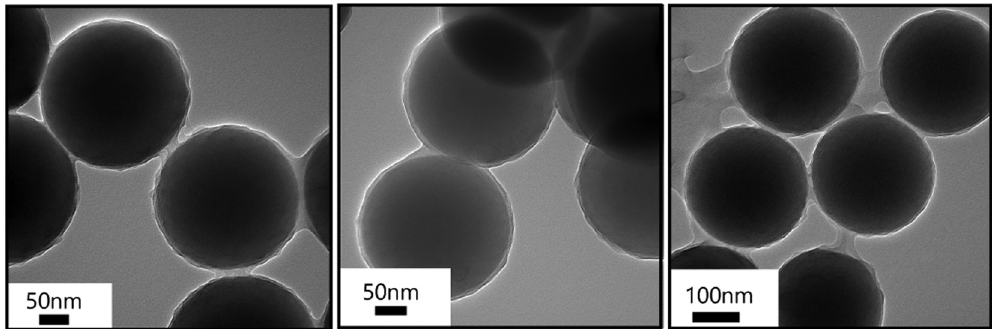
Figure 6: TEM images of the PHEMA/SiO 2 – MAPTMS particles. The polymer shell was cross - linked with